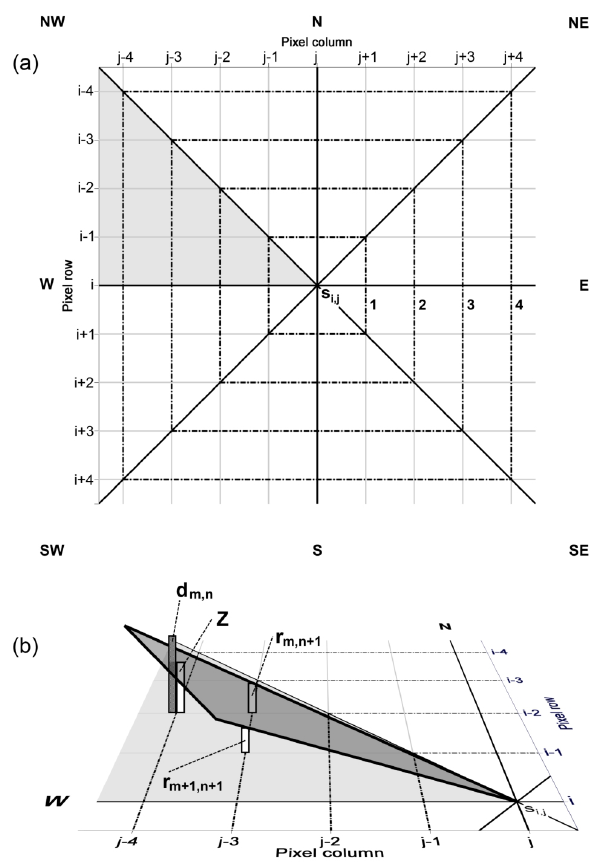
Fig. 2. (a) The viewshed calculation is divided into eight sectors based on the compass directions N, NE, E, SE, S, SW, W and NW (black lines) from the point s i,j . The DEM pixels are attributed to a certain ring (1, 2, 3, 4, ..., black dotted lines) depending on the pixel distance to s i,j . (b) The “reference planes” concept of Wang et al. (2000) is evaluated subsequently from the inner to the outer rings and is shown for an example in the 4th ring of the grey-shaded W-NW sector. The normalised camera position s i,j , as well as the neighbouring pixels r m,n + 1 and r m + 1 ,n + 1 (third ring) create a plane that checks if the pixel with the normalised elevation value d m,n is visible. In this case, d m,n is visible as the plane height Z at row m and column n is lower (adapted from Wang et al.,